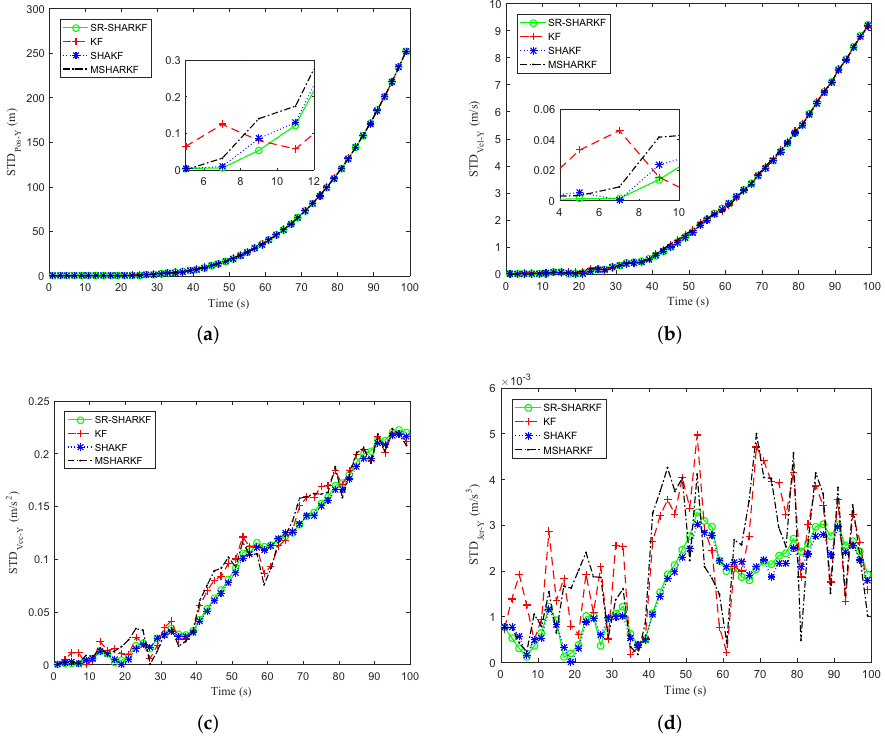
Figure 12. Dynamic parameter STD in the Y-axis direction. ( a ) Position STD. ( b ) Velocity STD. ( c ) Acceleration STD. ( d ) Jerk